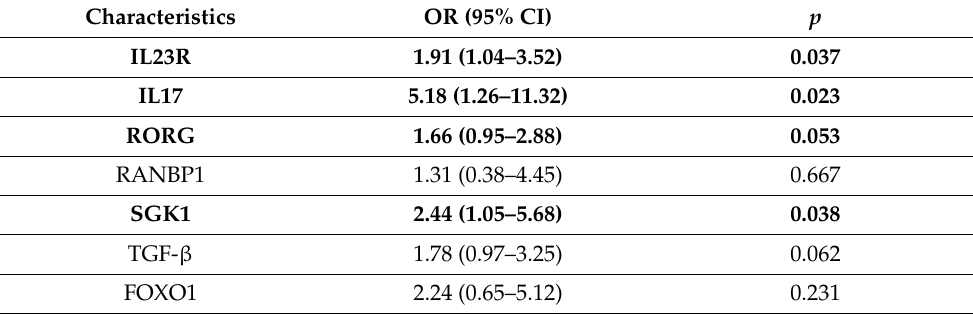
Table 3. Multivariable logistic regression analyses for the predictors of